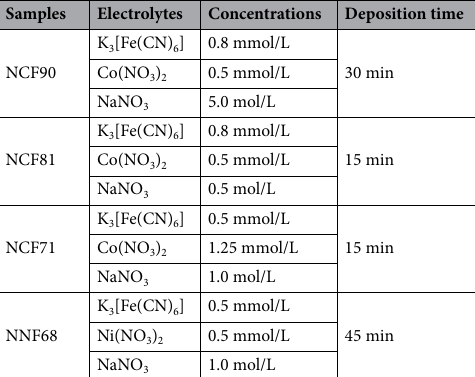
Table 2. Synthesis condition of PBA films by electrochemical decomposition method.